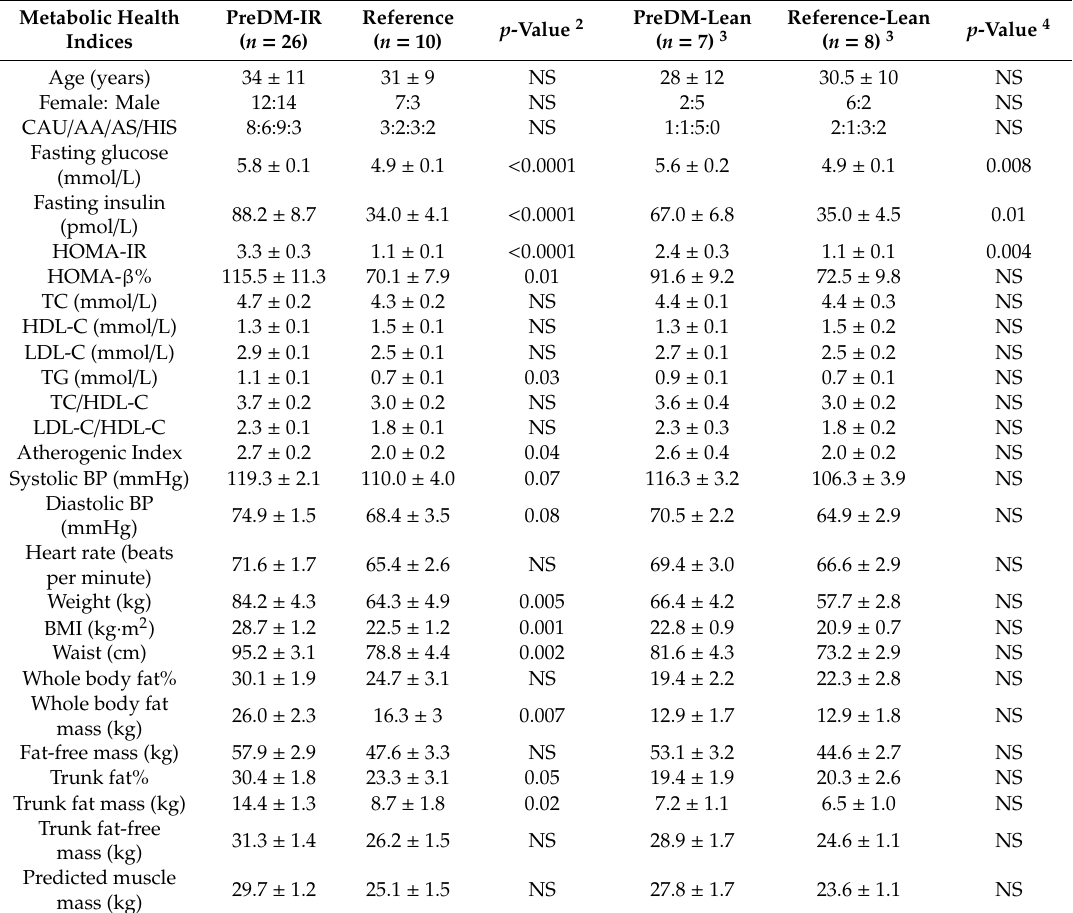
Table 3. Subject demographic and metabolic health characteristics 1 .